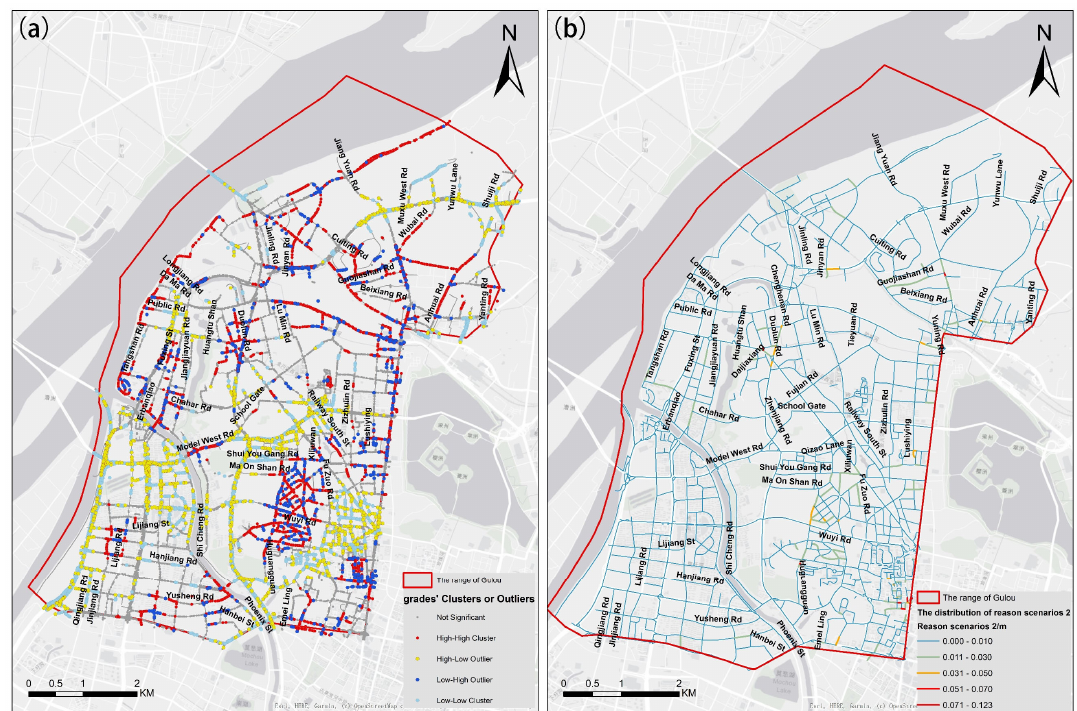
Figure 12. The distribution of sidewalks grades in Gulou ( a ) and the distribution of reason scenarios 1 ( b ).